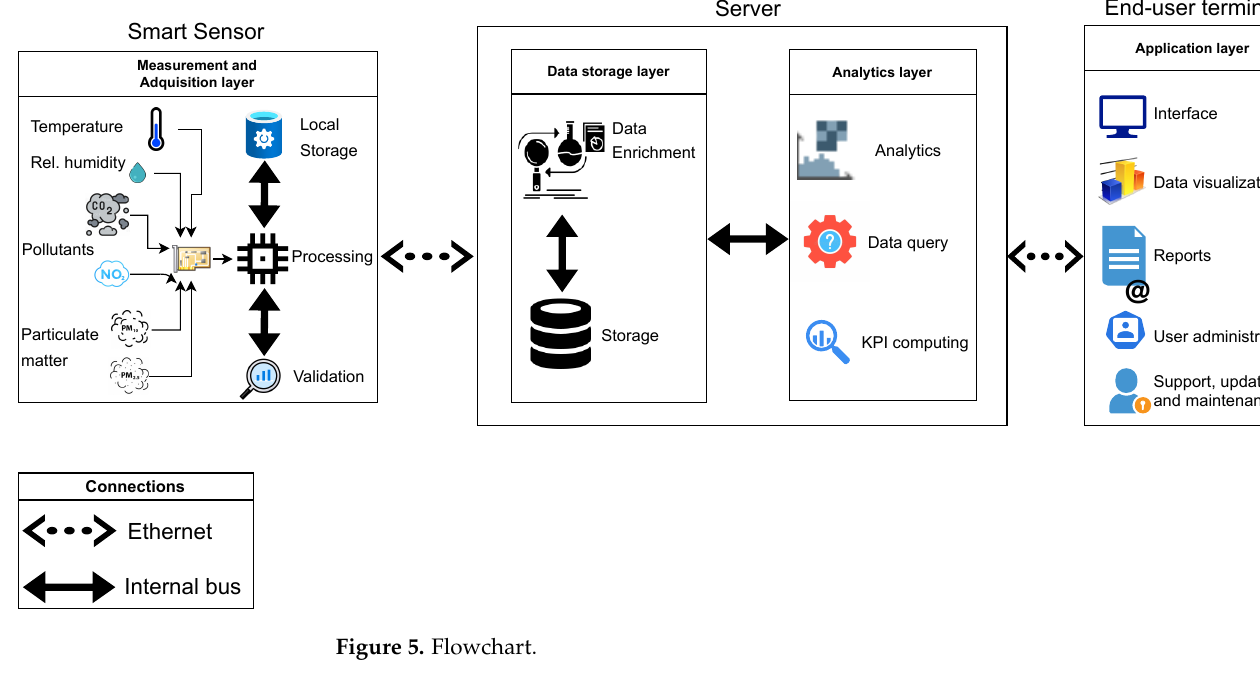
Figure 4. Process of hospital attention: Cyber-Physical System (CPS) On-Line Analytical Processing (OLAP); Key Performance Indicator (KPI).